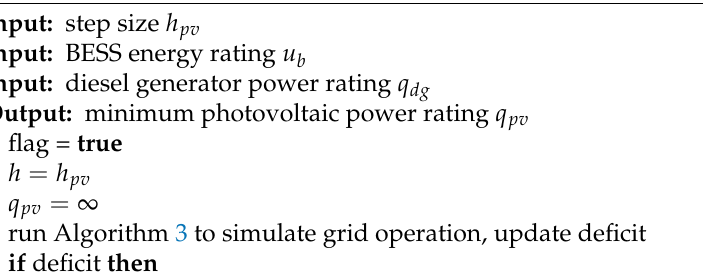
Algorithm 4 Minimum photovoltaic power rating to meet